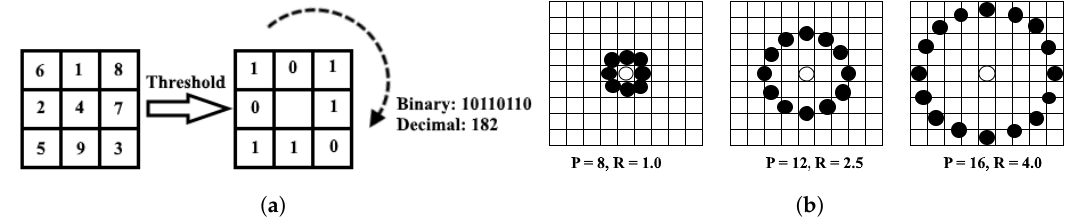
Figure 1. ( a ) The original local binary pattern (LBP) operator; ( b ) Circular neighbor-set for three different values of P, R.